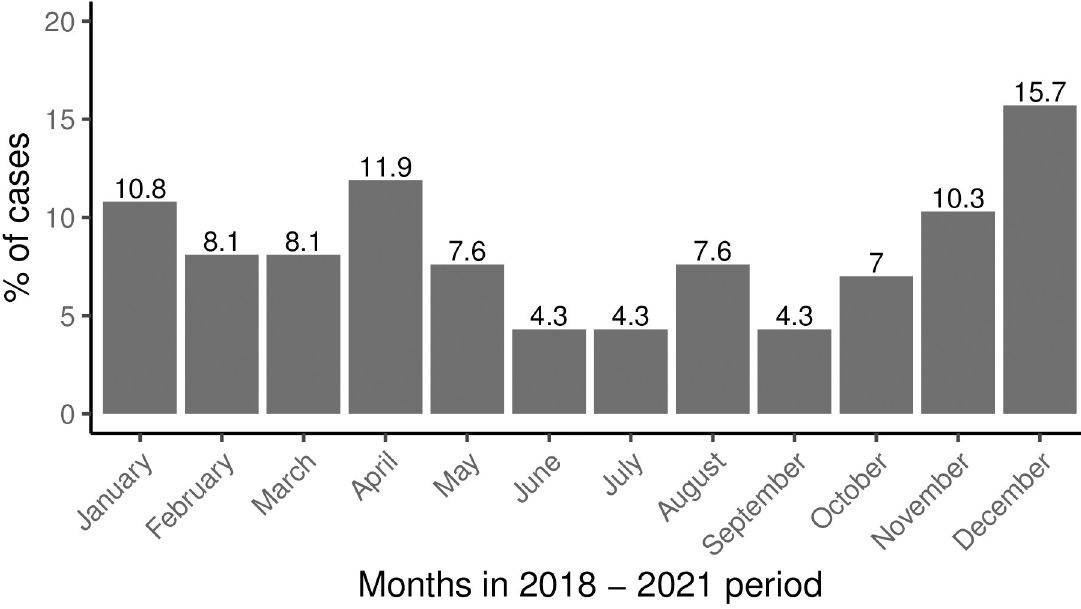
Fig 2. The proportion of snakebite cases managed and treated in Neno District